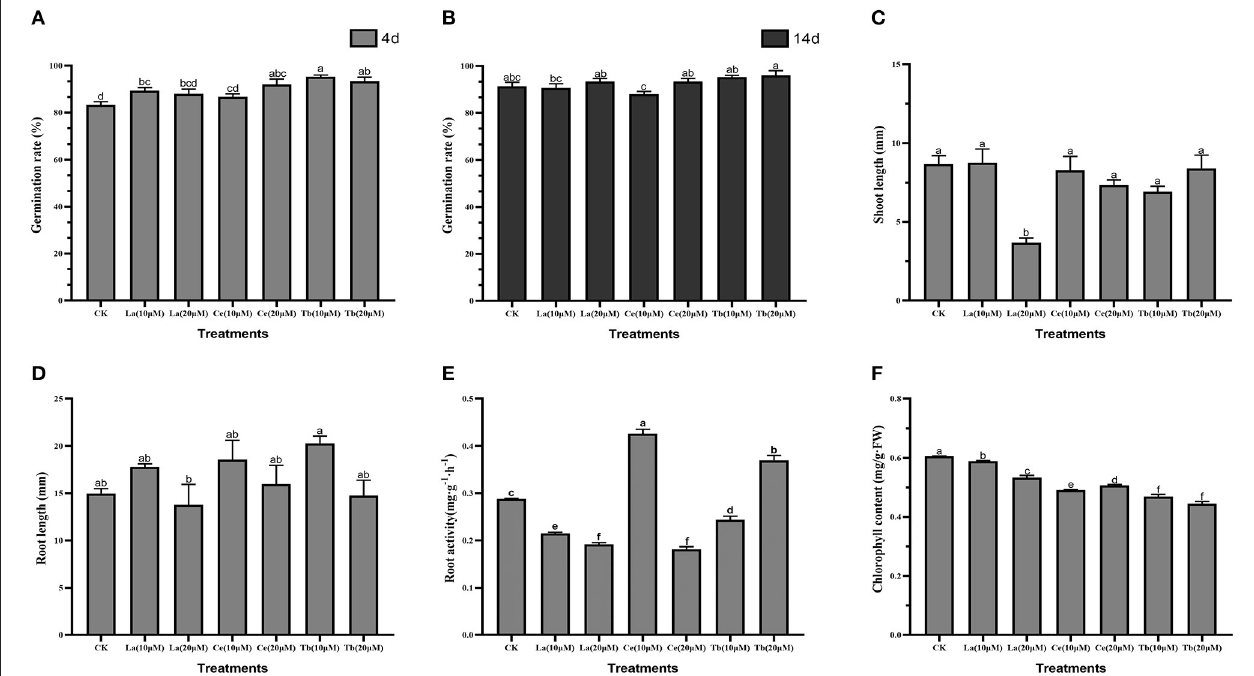
FIGURE 1 | Effects of La, Ce, and Tb (10 and 20 µ M) treatments on seed germination and seedling growth in Alfalfa. (A) Germination rate in 4 d, (B) germination rate in 14 d, (C) shoot length, (D) root length, (E) root activity, (F) chlorophyll content. Means with different letters are significantly different at p < 0.05.